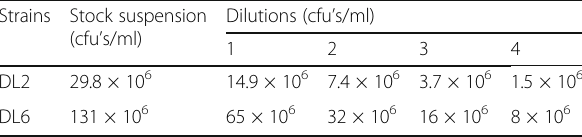
Table 1 Preparation of different cell concentration (cfu ’ s/ml) of the two selected isolates for leaf dipping bioassay technique Strains Stock suspension (cfu ’ s/ml)